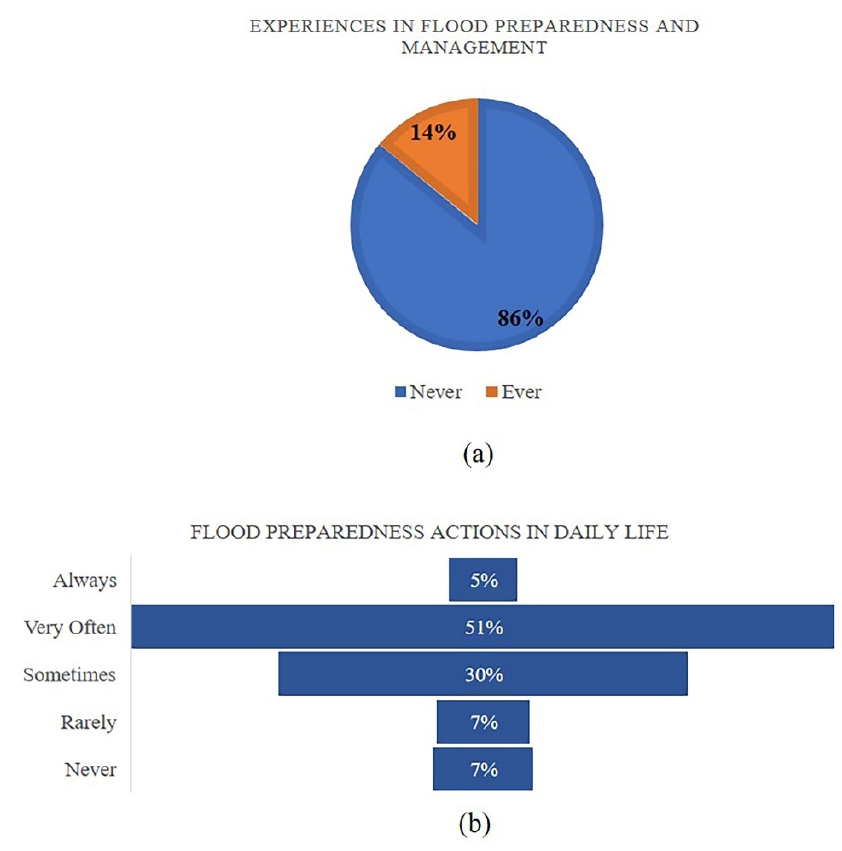
Figure 7. ( a ) Flood training experiences and ( b ) preparedness actions in their daily life (n =